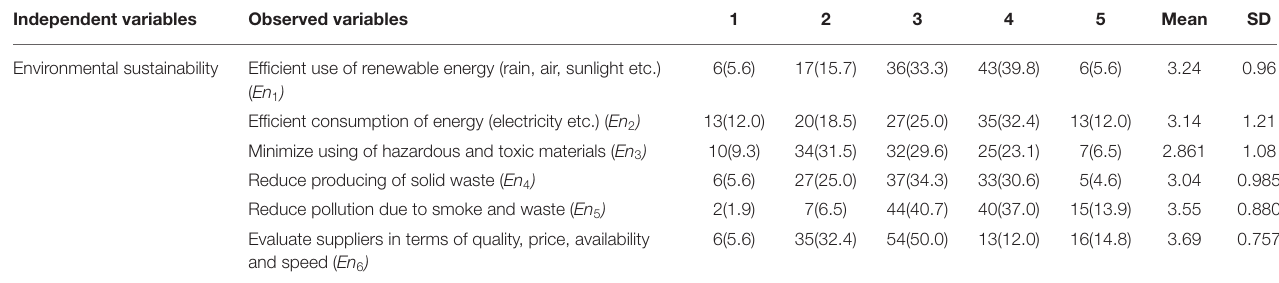
TABLE 9 | Responsiveness to the environmental sustainability of palm oil millers. Independent